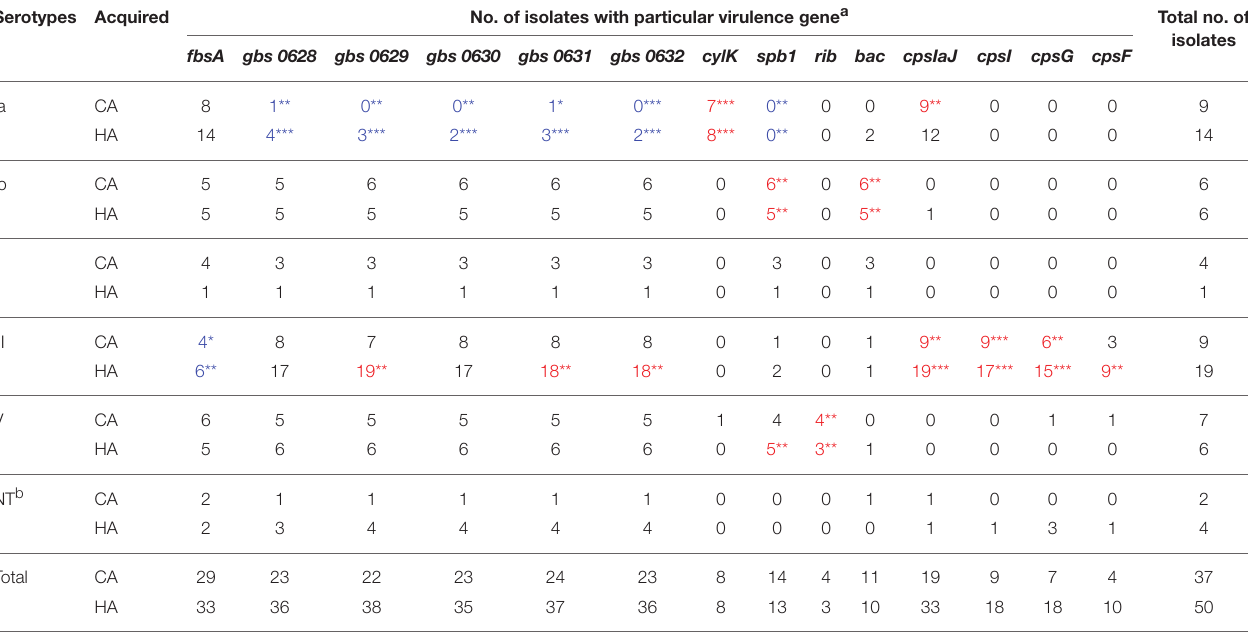
a Red and boldface indicates that there was a significant positive correlation between particular virulence gene and the serotype was found; blue and boldface indicates that there was a significant negative correlation between particular virulence gene and the serotype was found. * p < 0.05, ** p < 0.01, *** p < 0.001. b NT,